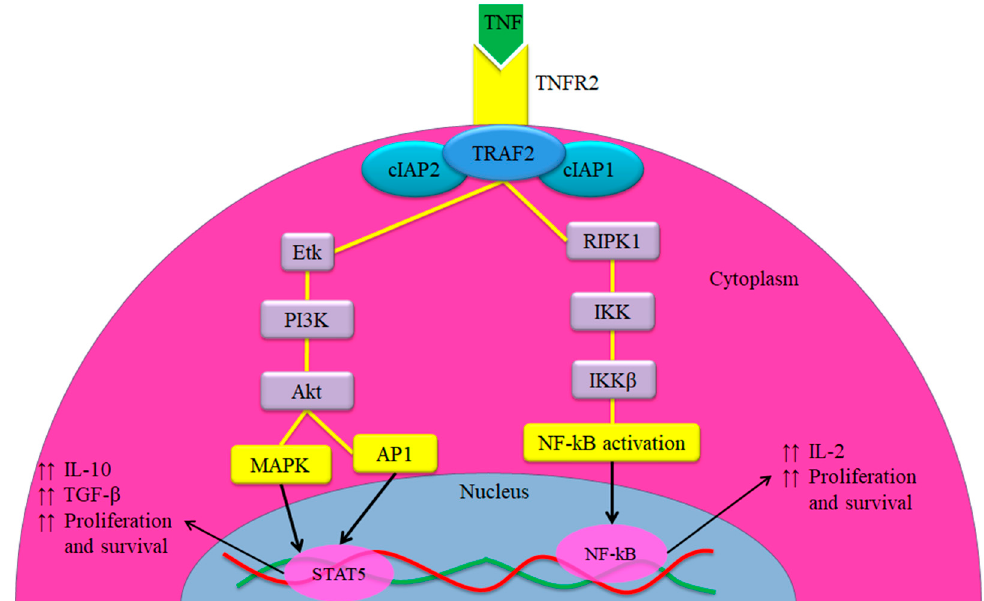
Figure 2. Overview of the TNF-TNFR2 signalling pathway in the immunosuppressive cells. The TNFR2 does not interact with an intracellular DD, while it interacts with complex I that consists of TRAF2 with cIAP1 and cIAP2, and induction of homeostatic signals. The signals travel from complex I either via receptor-interacting serine/threonine-protein kinase 1 (RIPK1) or Etk (a member of the Btk tyrosine kinase family). RIPK1 trigger NF- κ B via the IkB kinase (IKK) complex, which results in increasing the transcription of several genes associated positively with cell survival and proliferation. However, the Etk, through the PI3K/Akt pathway, is able to activate both AP1 and MAPK signalling pathways, which activate the promoter of proliferation, survival and other transcription factors. Further, it is associated with enhancing the phosphorylation of signal transducer and activator of transcription 5 (STAT5) that play a crucial role in immunosuppression (Adopted from Al-Hatamleh et al., 2019 [110]).